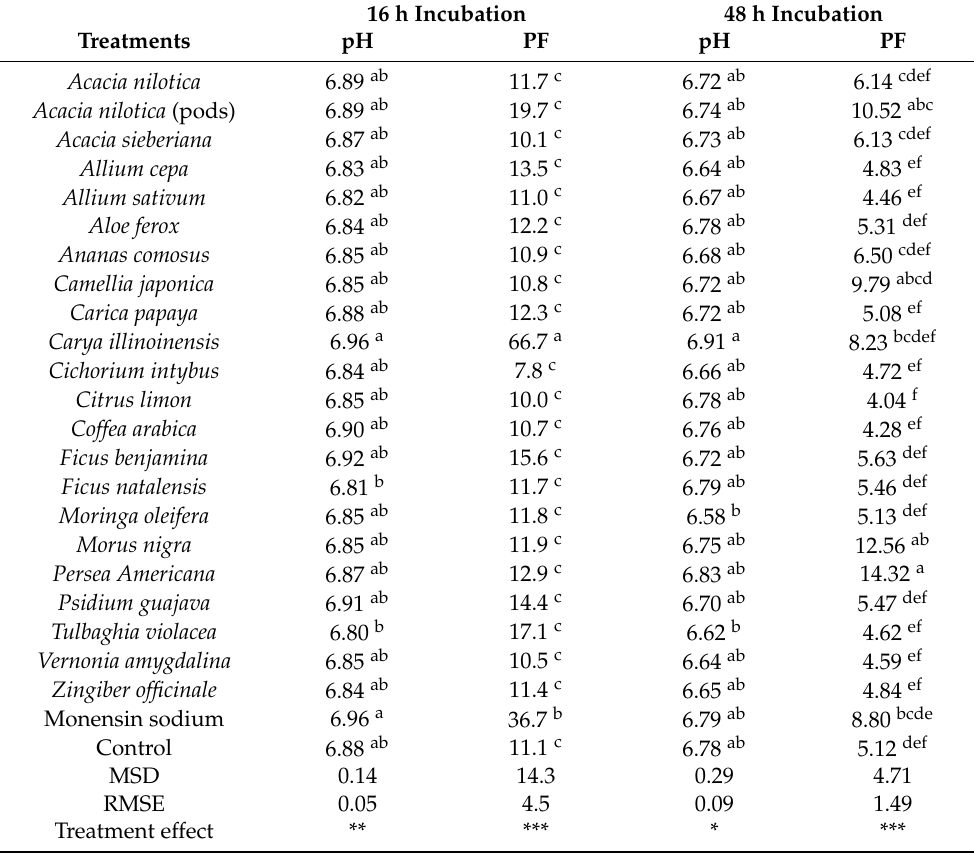
Table 4. Effect of plant extracts and monensin on ruminal pH and partitioning factor at 16 h and 48 h of incubation in